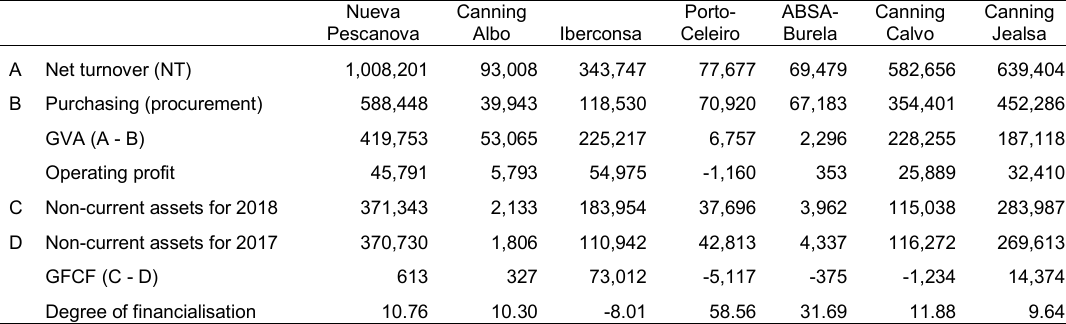
Table 3. Degree of financialisation (figures in thousands of euros).